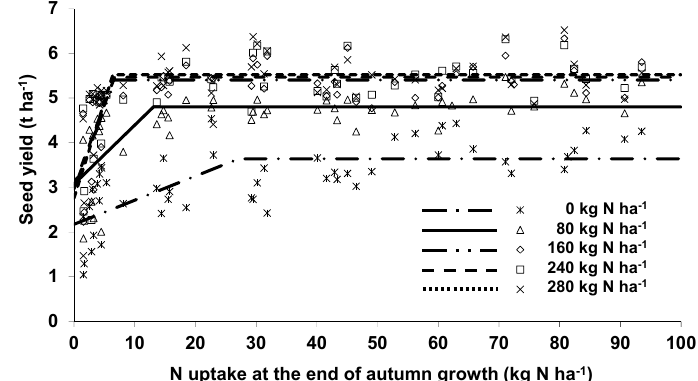
Figure 4. Relationship between N uptake of oilseed rape at the end of autumn growth and seed yield at different spring N fertilization levels (2010, 2011, 2013; for function parameters see Table 2).